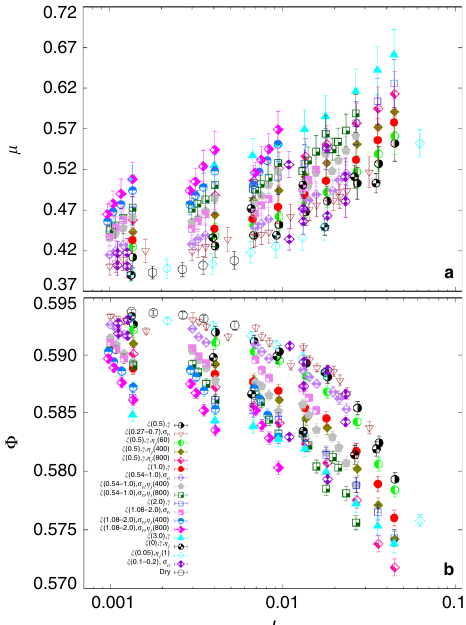
Fig. 2 Simulation results for friction and packing fraction. Apparent friction coef fi cient μ ( a ) and packing fraction Φ ( b ) as a function of the inertial number I for different sets of system parameters. The data points are average values over the steady state, and the error bars represent their standard deviation in each simulation during steady-state fl ow. For each set of simulations, the symbols and their colors correspond to the parameters that are varied with their ranges, all other parameters being kept constant.